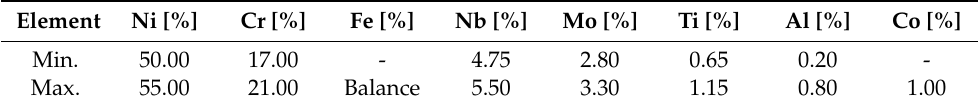
Table 1. Chemical composition alloy